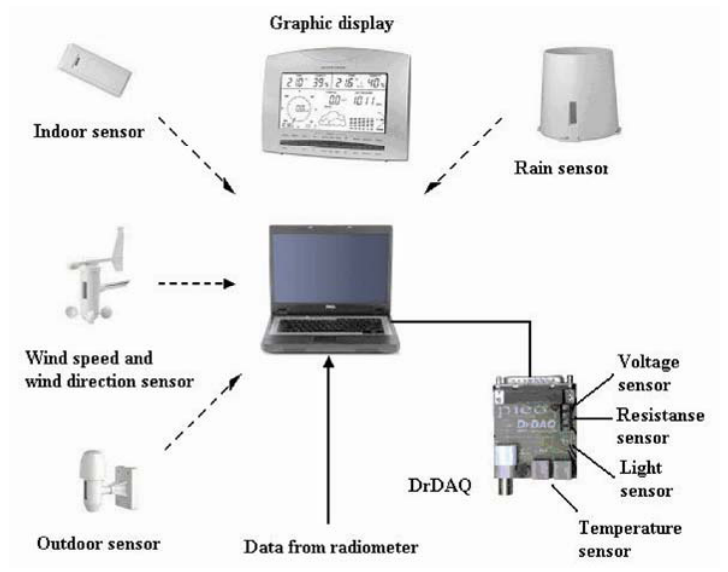
Fig 4. System of the Professional Remote Weather Station and Multifunctional Data logger